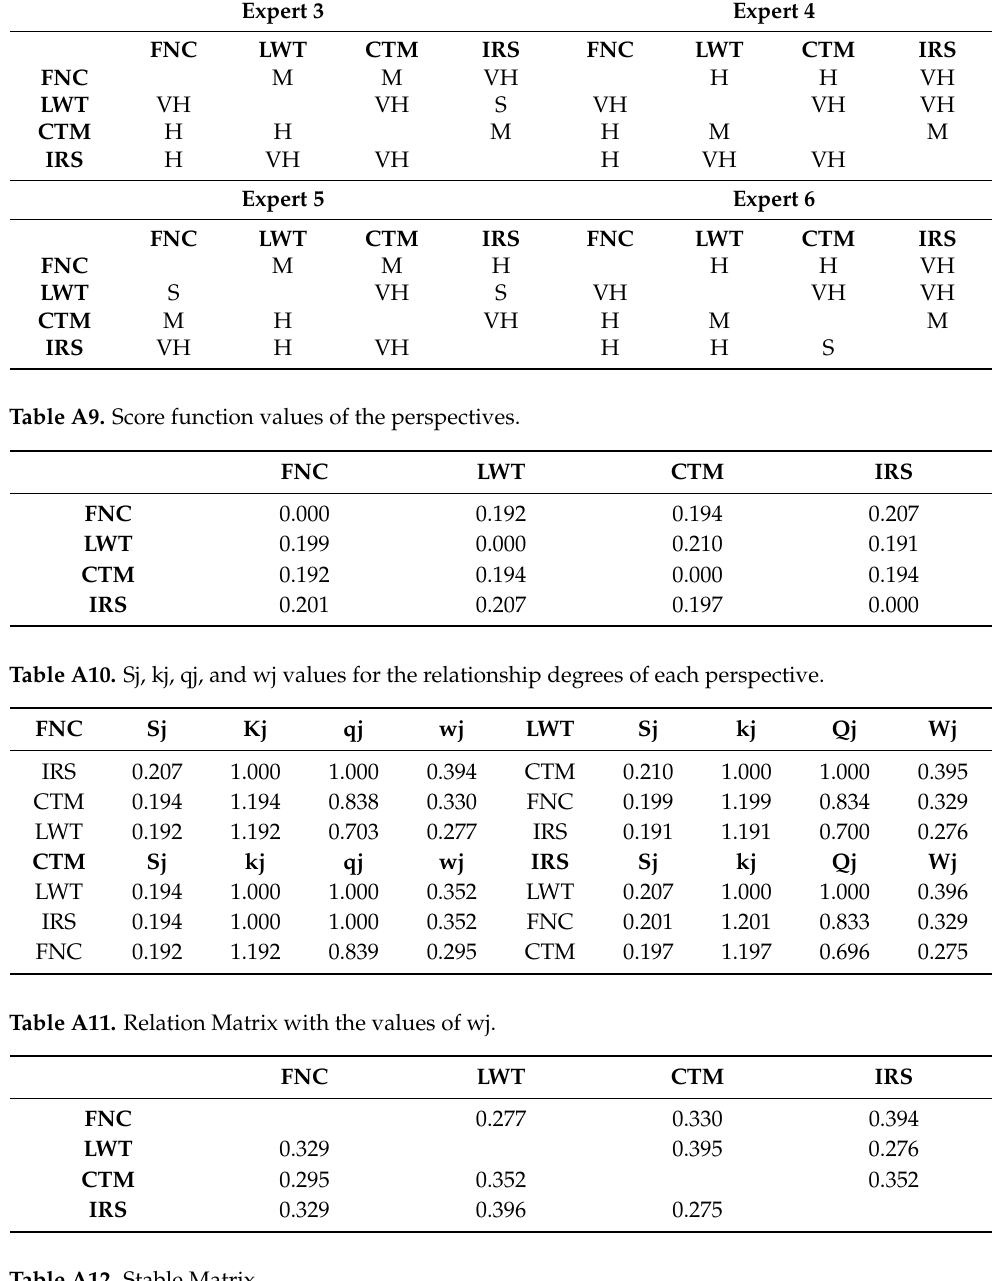
Table A12. Stable